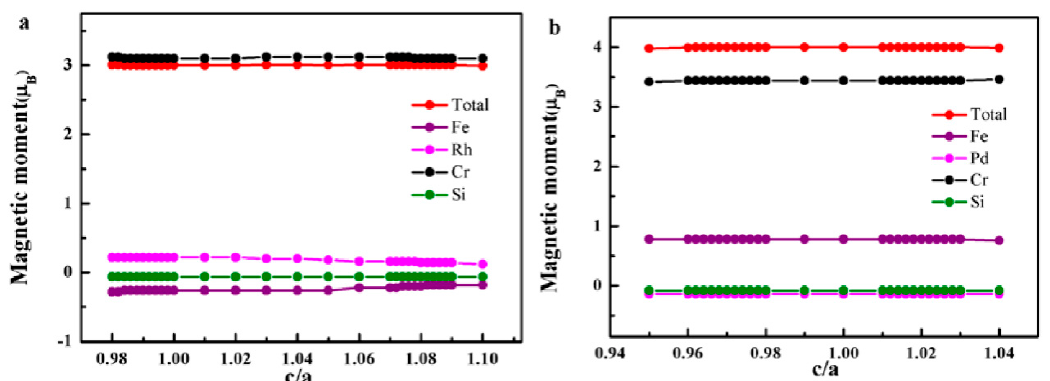
Figure 10. The total and partial magnetic moments as functions of c/a ratios for ( a ) FeRhCrSi and ( b ) FePdCrSi.